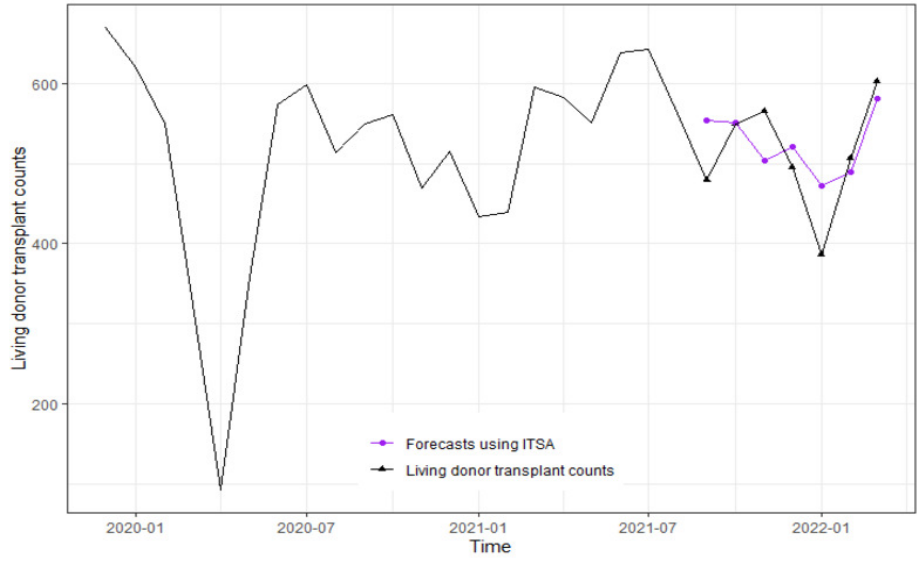
Figure 5. Forecasts of living donors from September 2021 to March